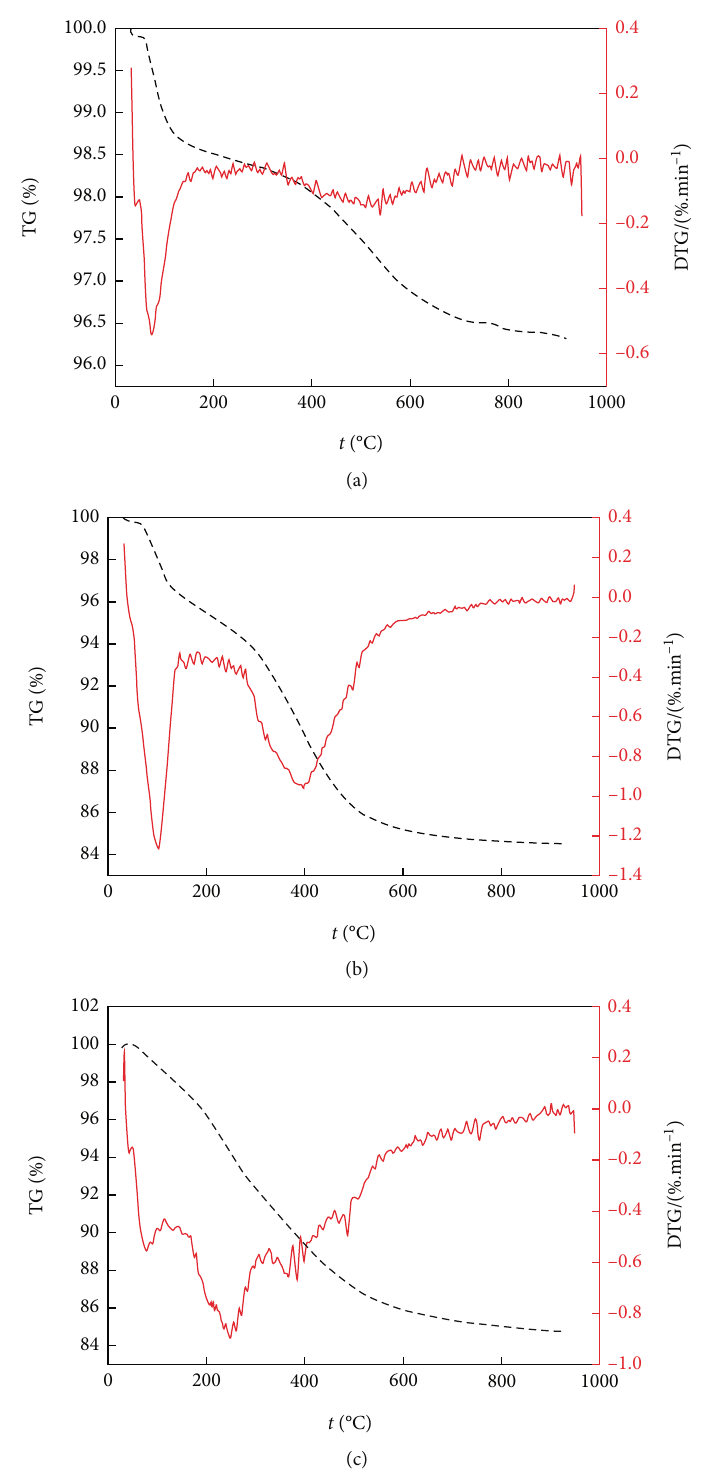
Figure 7: TGA and DTG curves for (a) SD, (b) SD+ MA, and (c) SD+